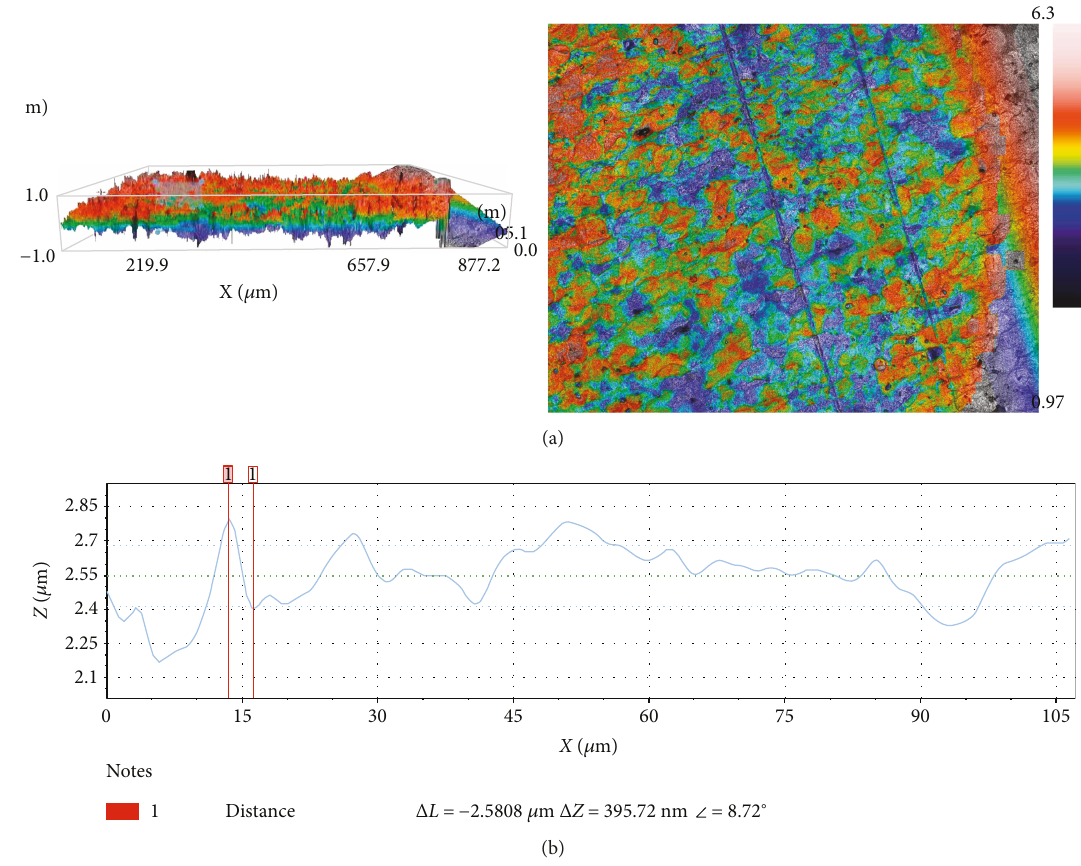
Figure 4: (a) Colored SEM image of the sample layer and 3D height pro fi le. (b) 2D surface roughness graph.